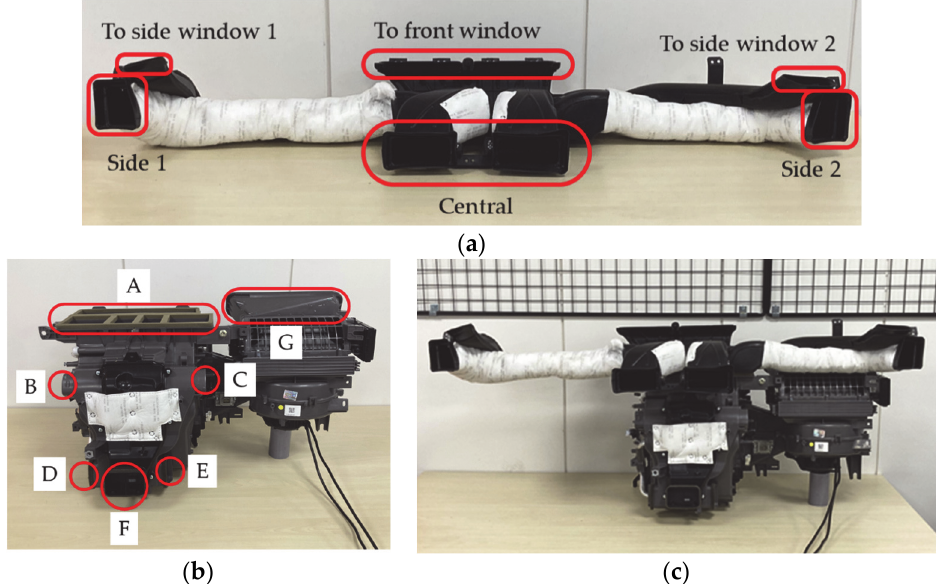
Figure 1. Parts of the HVAC system: ( a ) upper HVAC duct; ( b ) heater and evaporator system; and ( c ) installation of upper HVAC